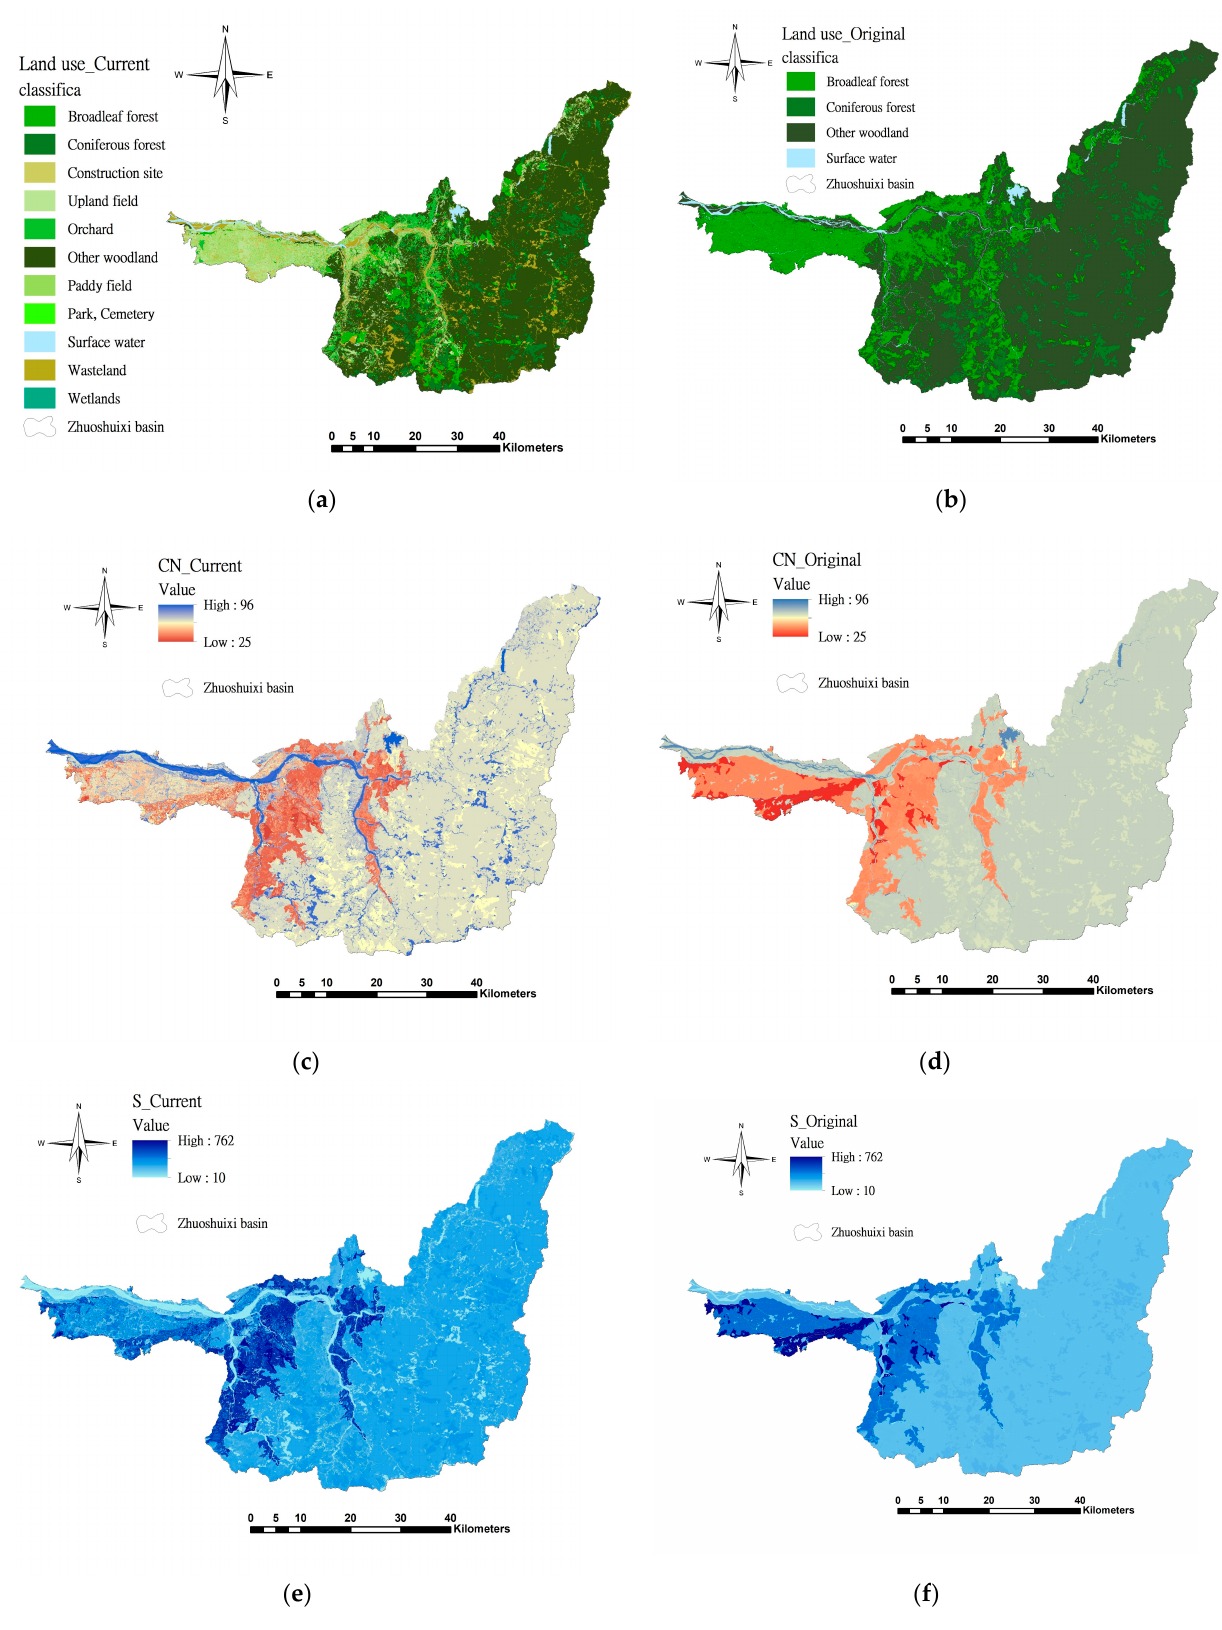
Figure 10. Basic map data under current and original conditions: ( a ) current land use map, ( b ) original situation land use map, ( c ) current situation CN value, ( d ) original situation CN value, ( e ) current situation water storage capacity, and ( f ) water storage capacity in the original situation.